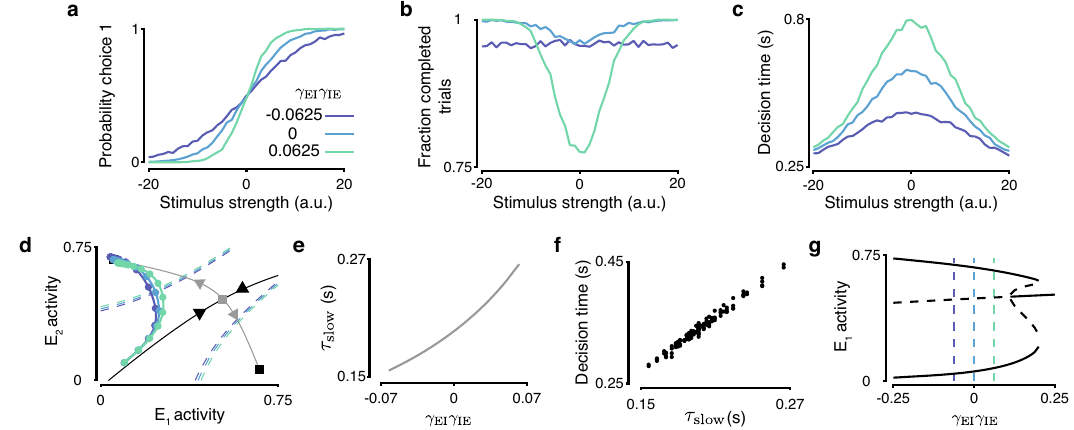
Fig. 3 | Inhibitory circuit motifs mediate the speed-accuracy trade-off in decision-making. a – c Contraspeci fi c circuits are faster and less accurate, whereas ipsispeci fi c circuits are slower and more accurate than nonspeci fi c circuits. Psy- chometric functions ( a ), probability of trial completion ( b ), and chronometric functions ( c ) for circuits with different inhibitory motifs. d Contraspeci fi c circuits deviate to a choice attractor earlier and faster than ipsispeci fi c circuits. Single-trial trajectories are shown for three circuits with different inhibitory motifs, in 50ms time steps (dots) for 0 stimulus strength. Noise is reduced by 50% for illustration clarity.Thedecisionthresholdforeachcircuitisshownbythedashedline.Squares indicate choice attractors, triangle indicates the saddle point. The stable (black)